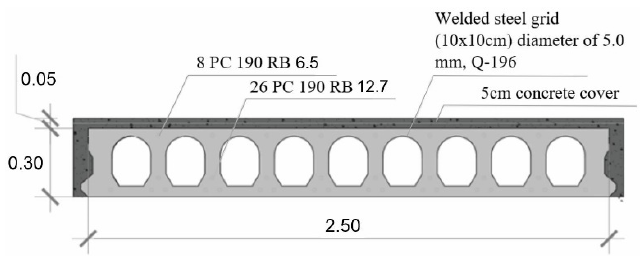
Figure 5. Cross-section of the hollow-core slab.